Question: Briefly state, in one sentence, what is plotted here.
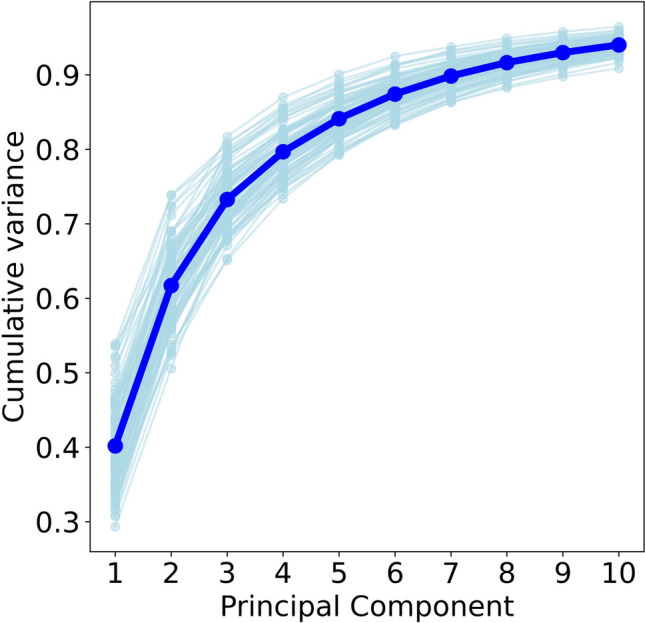
Answer: Cumulative variance explained in hidden unit activity by principal components of the best RNN architecture (LSTM cell with weber noise, A2C algorithm and no entropy regularization): Light blue lines denote cumulative variance explained for each RNN instance. Dark blue line denotes mean cumulative variance explained over all RNN instances